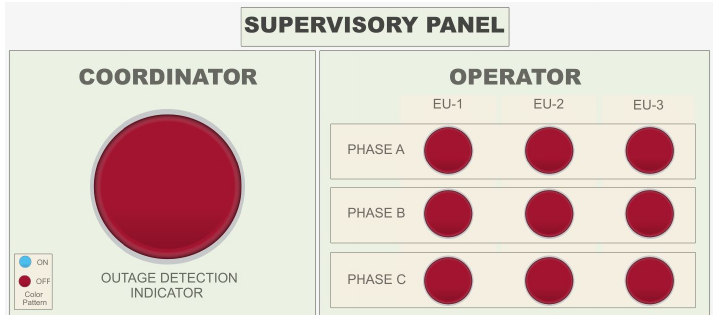
Figure 17. Supervisory Panel signaling concerning EUs disconnection after outage event